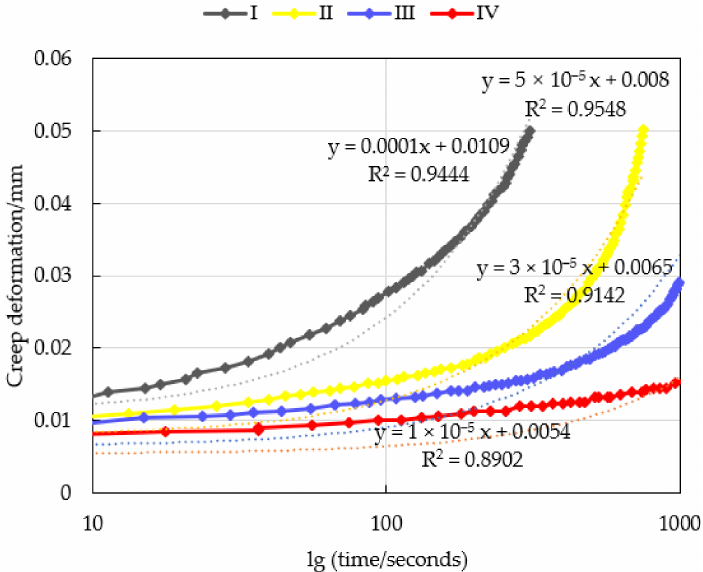
Figure 17. Deformation–time semilog curves.